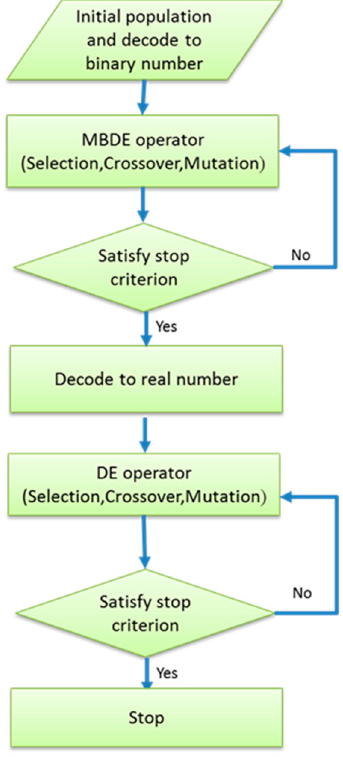
Figure 4. Flowchart of two-stage DE.